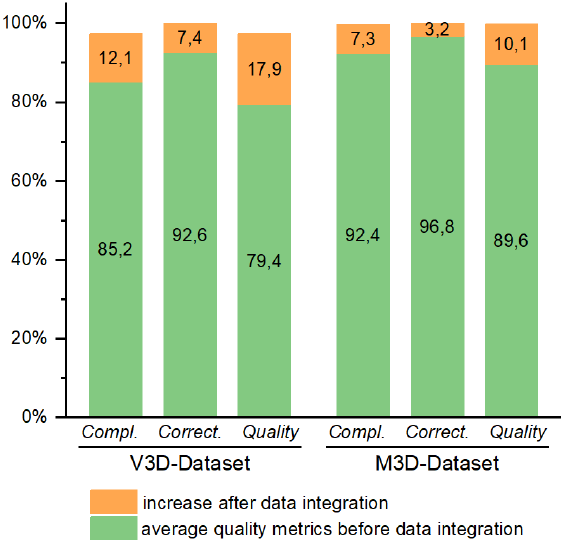
Figure 10. Increase of the Completeness [%], Correctness [%] and Quality [%] after data